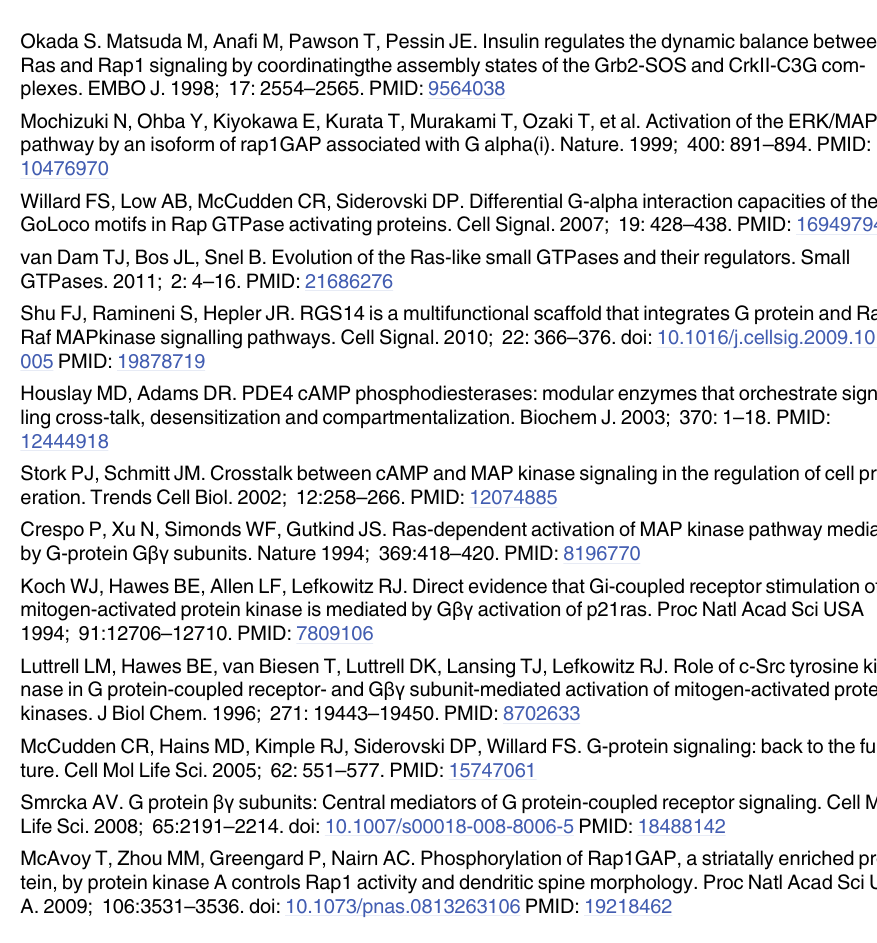
PLOS ONE | DOI:10.1371/journal.pone.0118712 March 5,